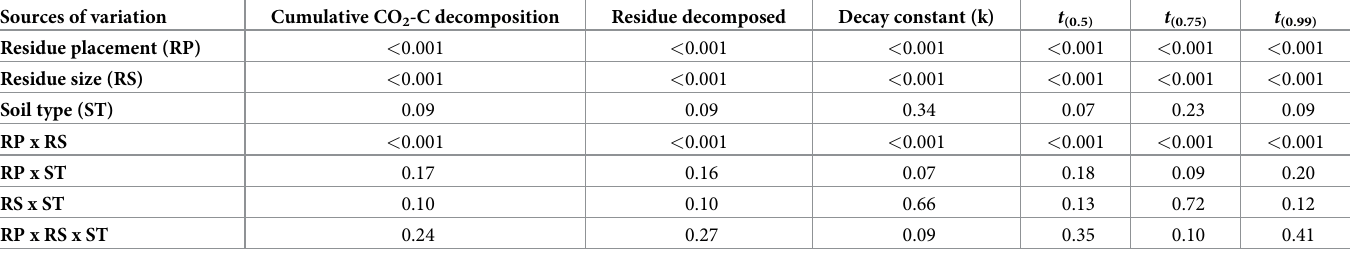
Table 3. Analysis of variance (ANOVA) P values for cumulative decomposition rate, percentage residue decomposed, decay constant (k) and associated parameters over 50-days’ laboratory incubation study for barley residue decomposition conducted at the Aberdeen Research and Extension Center, Aberdeen, ID, USA. Sources of